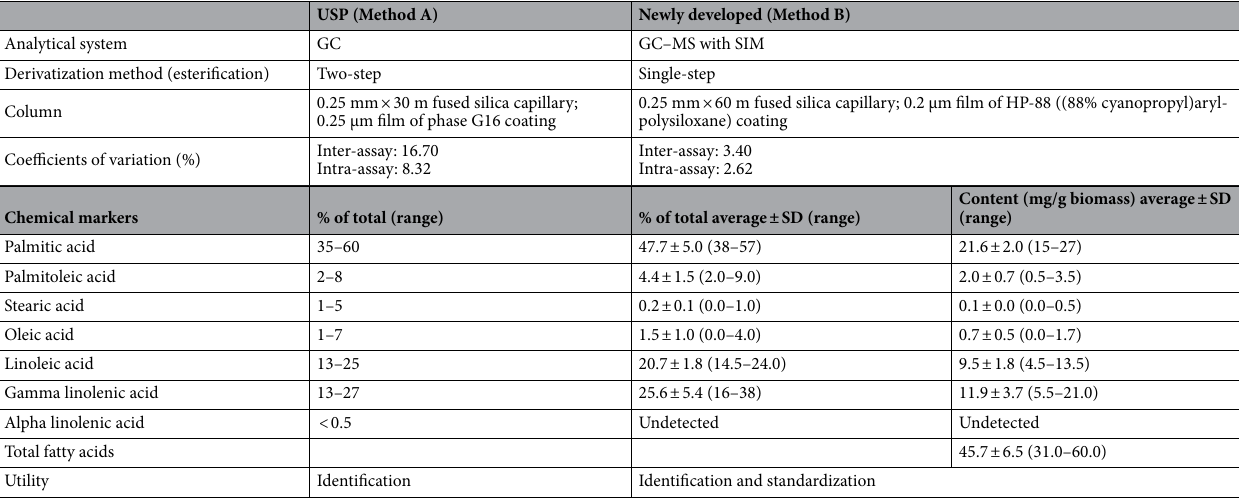
Table 3. Comparison of the USP method (monograph # 2181) for Limnospira biomass with the newly developed method. Chemical marker values for the new method represent average (range) values from 32 samples.